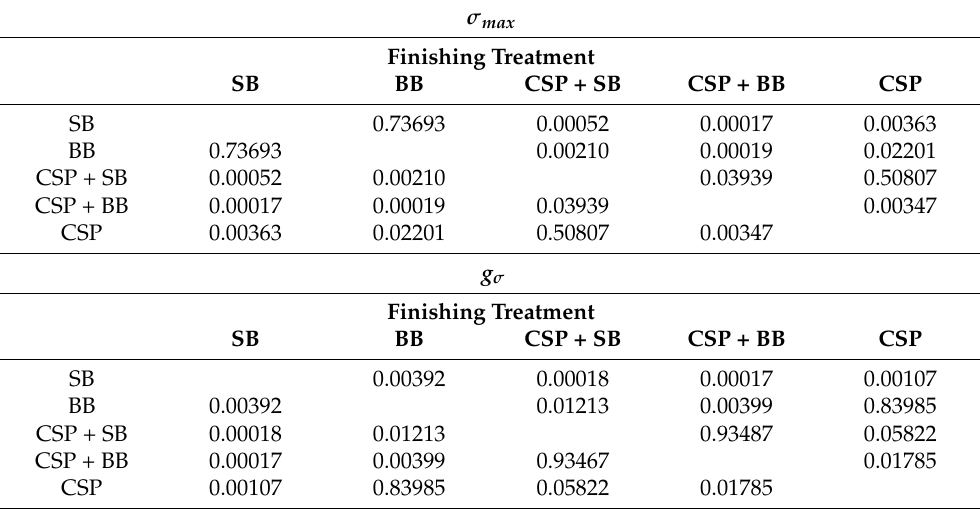
Table 5. Comparative analysis of the significance of differences (post-hoc/Tukey’s test) between the mean values of the maximum compressive stresses σ max and the stress depth incidence g σ after treatment with different methods. The red color indicates the probability level for which there are statistically significant